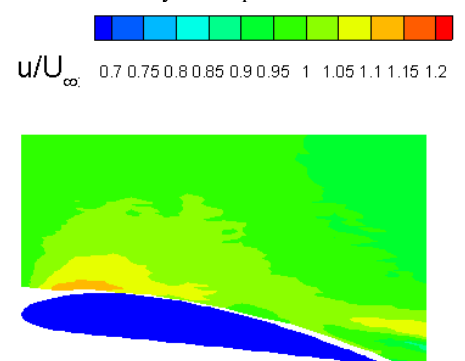
Fig . 3. u/U ∞ at Re=5x10 4 and α=8º for partial flexible wing (and z/s=0.1)